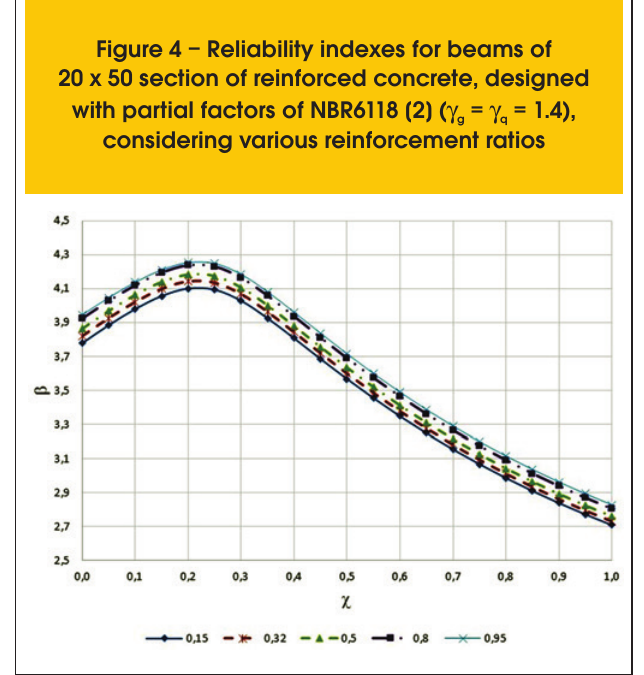
Figure 4 – Reliability indexes for beams of 20 x 50 section of reinforced concrete, designed with partial factors of NBR6118 [2] ( g = g = 1.4), g q considering various reinforcement